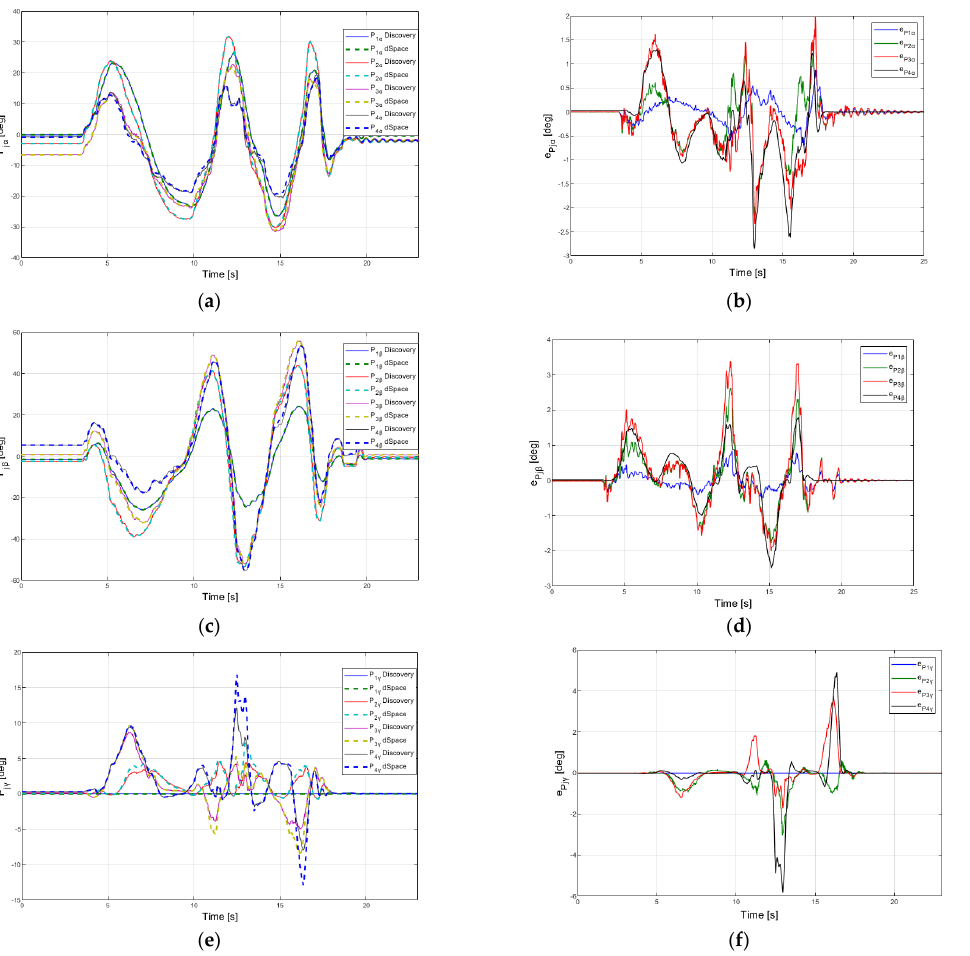
The variations of the platform’s orientations are presented in Figure 11 (parameter